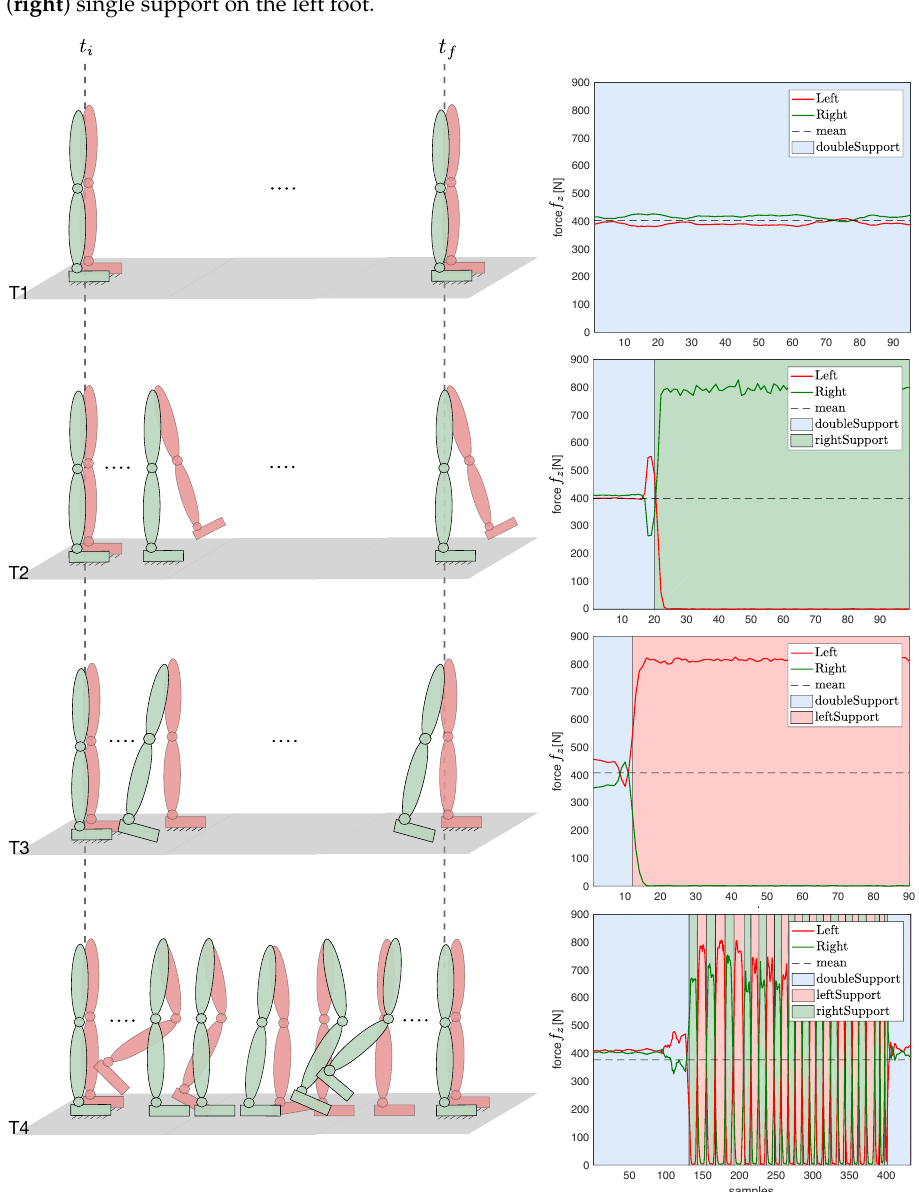
Figure 6. Tasks representation from initial time t i to final time t f ( left ); and feet contact pattern classification obtained via Algorithm 1 ( right